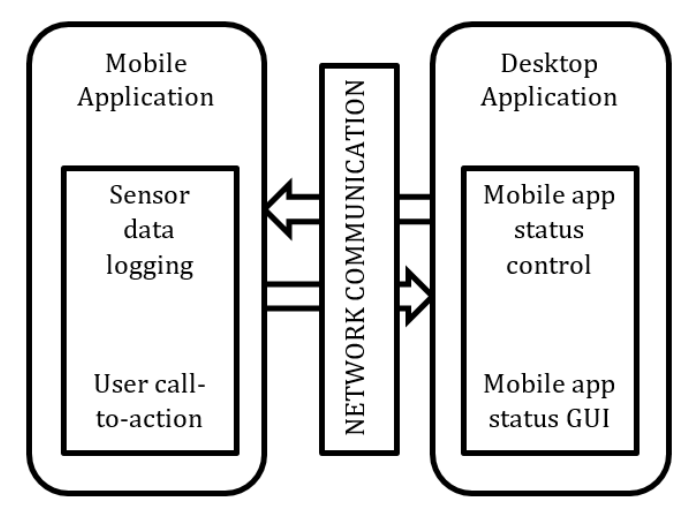
Figure 3. System dataflow